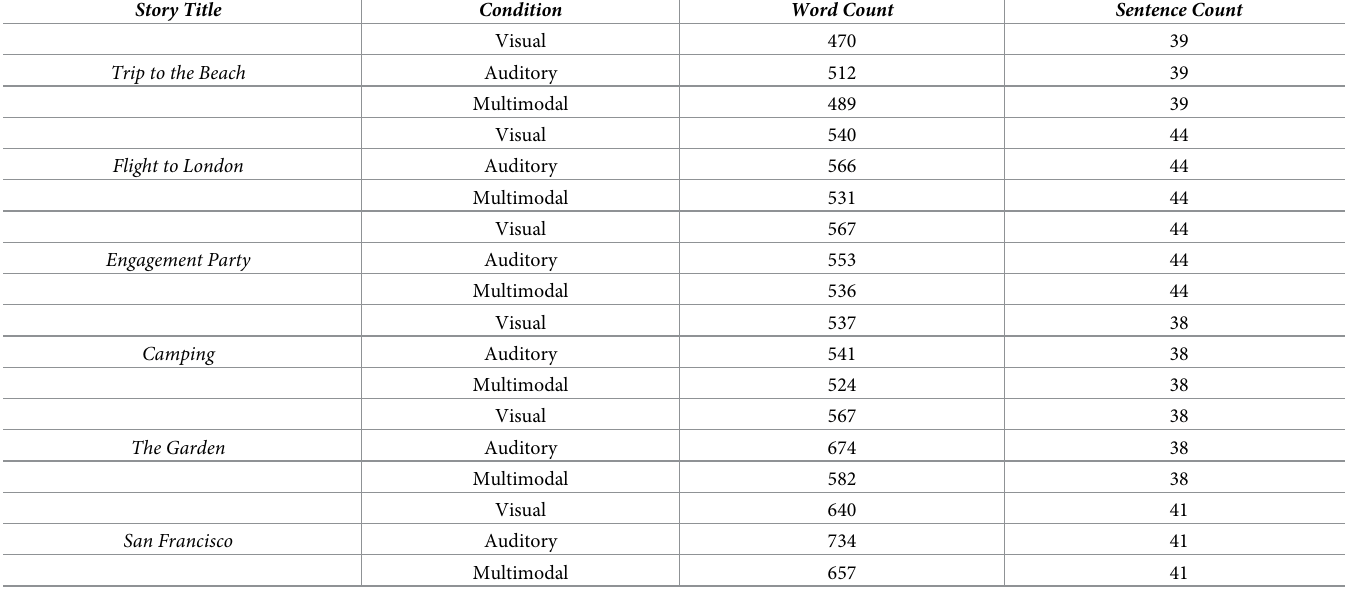
Table 1. Word and sentence counts per story and